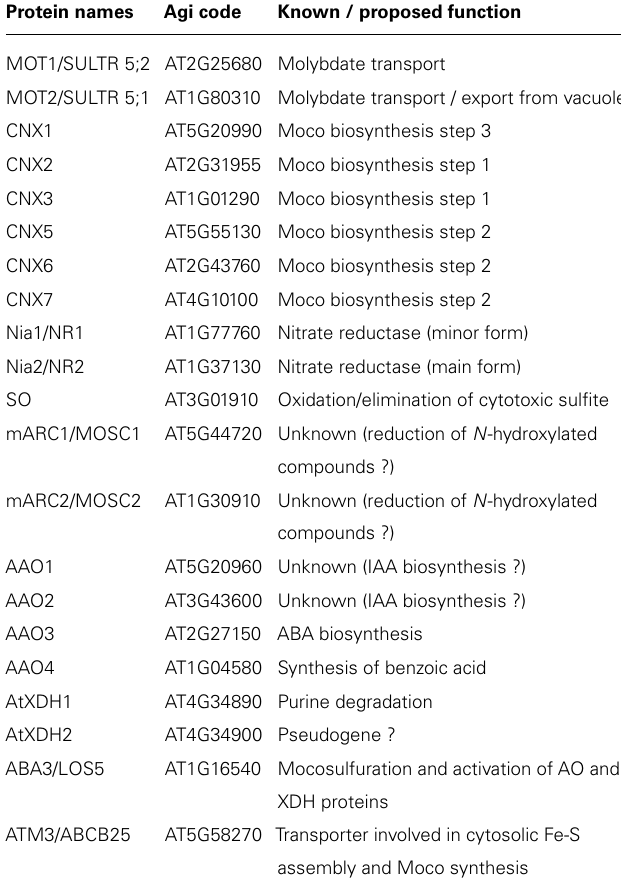
Table 1 | Components of molybdenum metabolism in higher plants ( Arabidopsis thaliana ). Protein